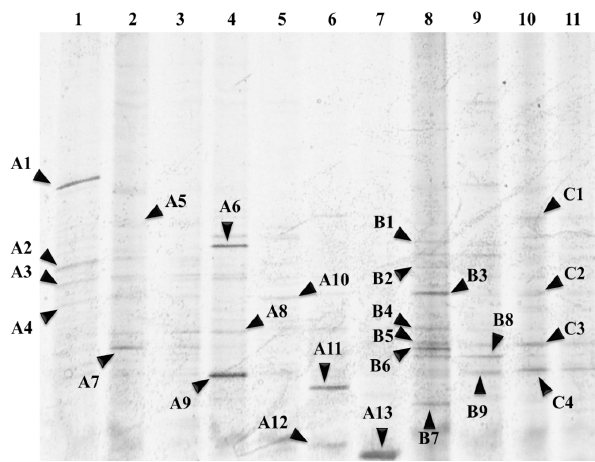
Figure 3. Comparison of DGGE analysis profiles of soil communi- ties during anaerobic incubations. Samples from 0, 30, 90 and 160 days of incubation with ferrihydrite + NH 4 Cl + NaHCO 3 (lanes 1–4); 160 days of incubation with only ferrihydrite (lane 5); ferric chloride + NH 4 Cl (lane 6); ferric citrate + NH 4 Cl (lane 7); 120 days incubation with ferrihydrite + NH 4 Cl + NaHCO 3 + organic carbon (band 8); ferrihydrite + NH 4 Cl + organic carbon (lane 9). Samples from 6 and 120 days of incubation without any addition (lanes 10 and 11) were used as controls.